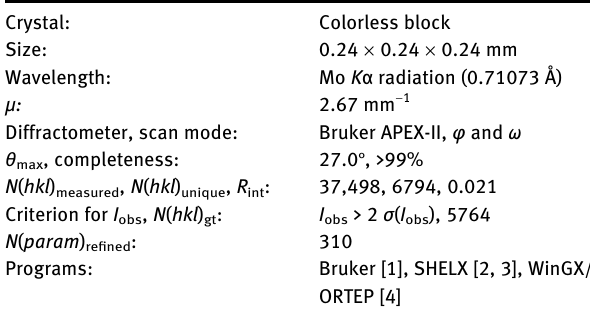
Table  : Data collection and